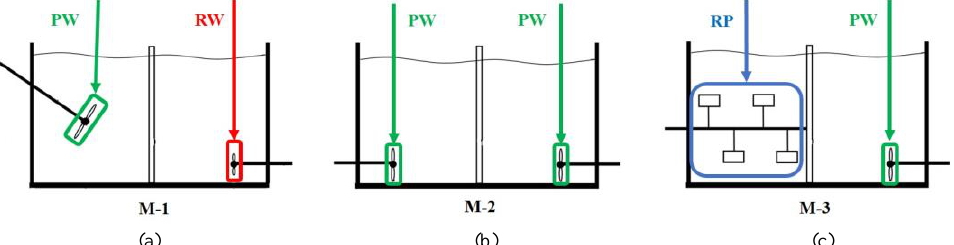
Fig. 2. Mixing configurations investigated in the laboratory digester: (a) M-1 includes a pointed blade propeller (PW) and a rounded blade propeller (RW); (b) M-2 includes two pointed blades propellers (PW); (c) M-3 includes a pointed blades propeller (PW) and a paddle system